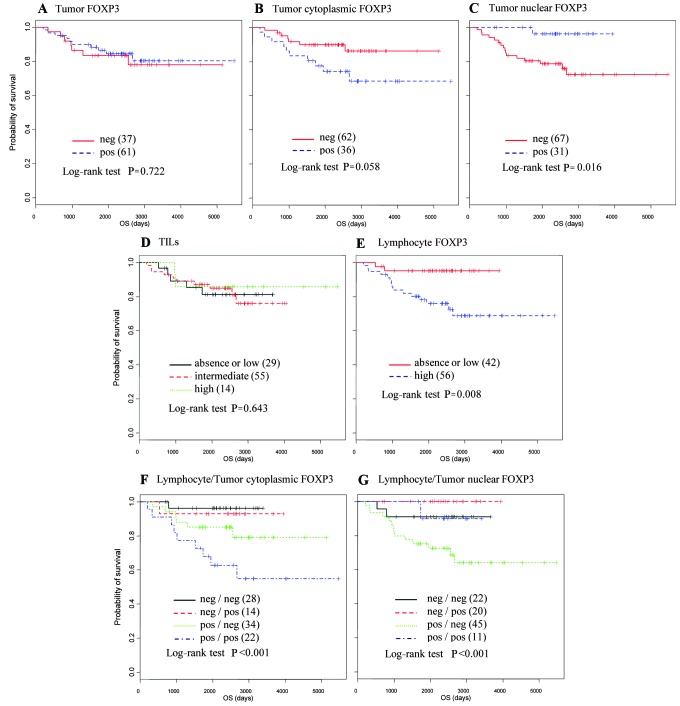
Kaplan-Meier curves for overall survival (OS) associated with forkhead box protein 3 (FOXP3) expression in breast cancer. Kaplan-Meier curves in two groups divided into (A) FOXP3-positive (+/−, −/+ and +/+, cytoplasmic/nuclear expression) and -negative (−/−), (B) cytoplasmic FOXP3-positive (+/− and +/+) and -negative (−/+ and −/−) and (C) nuclear FOXP3-positive (−/+ and +/+) and -negative (+/− and −/−) expression in tumor cells. Intensities of (D) tumor-infiltrating lymphocytes (TILs) and (E) FOXP3+ lymphocytes were stratified as follows: absent-low, intermediate and high infiltration in (D); negative (absent-low) and positive (high infiltration of FOXP3+ lymphocytes) in (E). Kaplan-Meier curves in the four groups according to infiltration of (F) FOXP3+ lymphocytes and cytoplasmic or (G) nuclear FOXP3 in tumor cells. Number of specimens in each group is shown in parenthesis. P-values were calculated using the log-rank test. neg, negative; pos, positive.